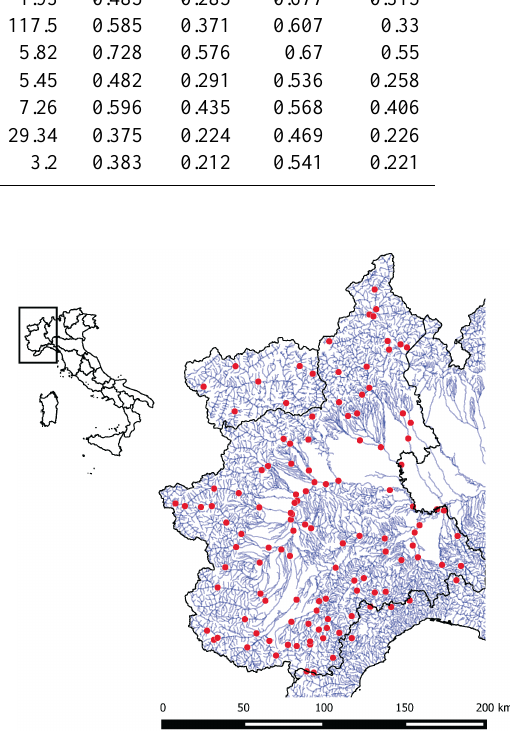
Figure 2. Location of gauging stations used in the